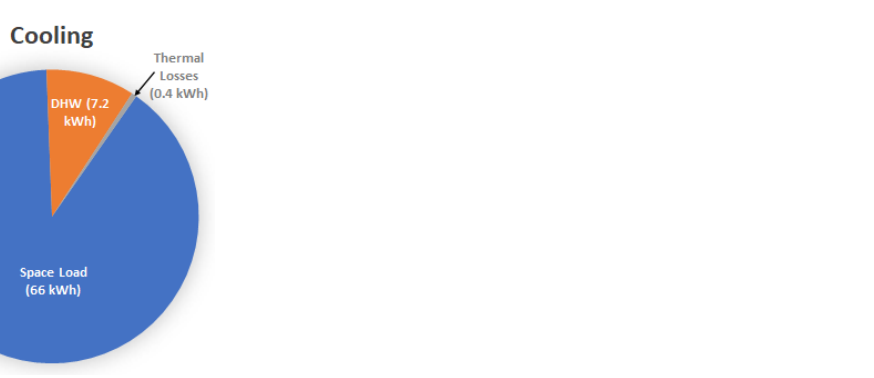
Figure 3. The daily thermal energy demands for the building services system in the cooling season.